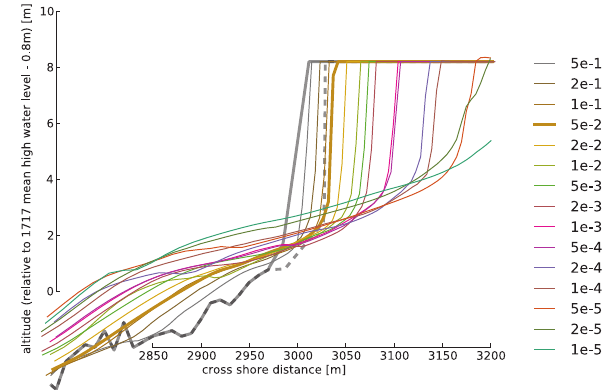
Fig. 3. Modelled and reconstructed profiles of the 1717 storm at Egmond aan Zee. Gray solid line: pre-storm reconstructed profile. Gray dashed line: post-storm reconstructed profile. Colored lines: modelled profiles. Thick colored line: modelled profile that best matches the pre- and post-storm reconstructions within the mea- sured area with an occurrence probability 5 / 100 per year (return pe- riod